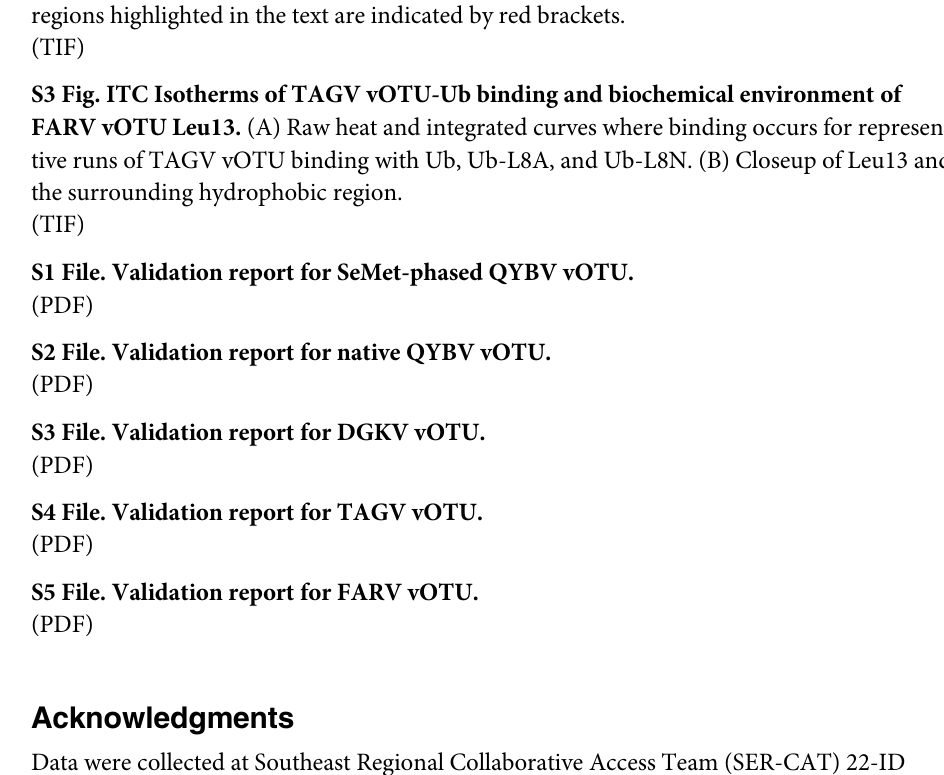
square deviation of vOTU alpha carbons when measured against CCHFV vOTU. General regions highlighted in the text are indicated by red brackets. S3 Fig. ITC Isotherms of TAGV vOTU-Ub binding and biochemical environment of FARV vOTU Leu13. (A) Raw heat and integrated curves where binding occurs for representa- tive runs of TAGV vOTU binding with Ub, Ub-L8A, and Ub-L8N. (B) Closeup of Leu13 and the surrounding hydrophobic